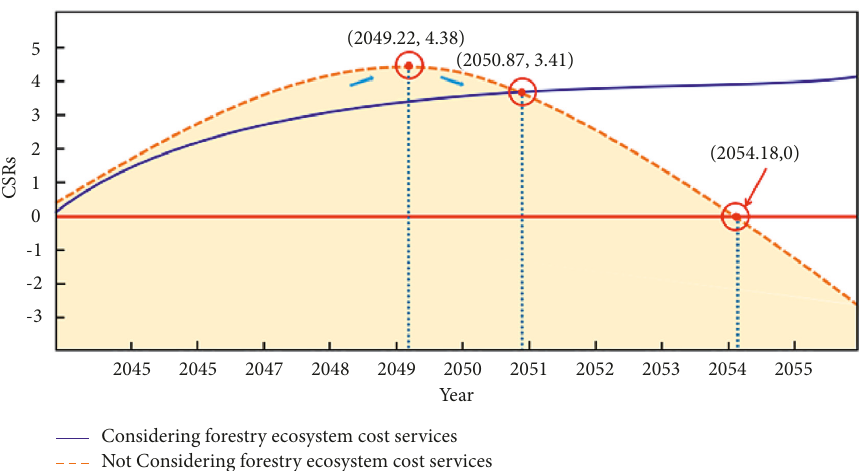
Figure 6: Determination of transition points for carbon sequestration system of the case.